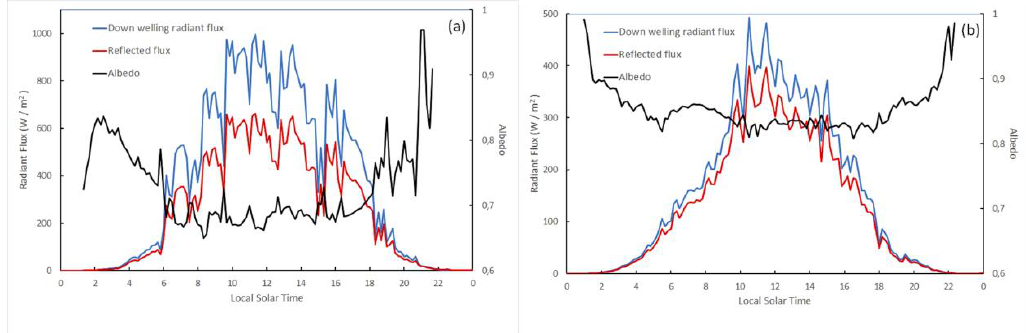
Figure 5. Diurnal evolution of the down welling radiant flux (solid blue line), the reflected radiant flux (solid red line), and the albedo (solid black line) at Johnsons Glacier. Day with clear sky (December 24 2009) ( a ) and an overcast day (December 22 2011) ( b ). Albedo and radiation values are given every 10 min.